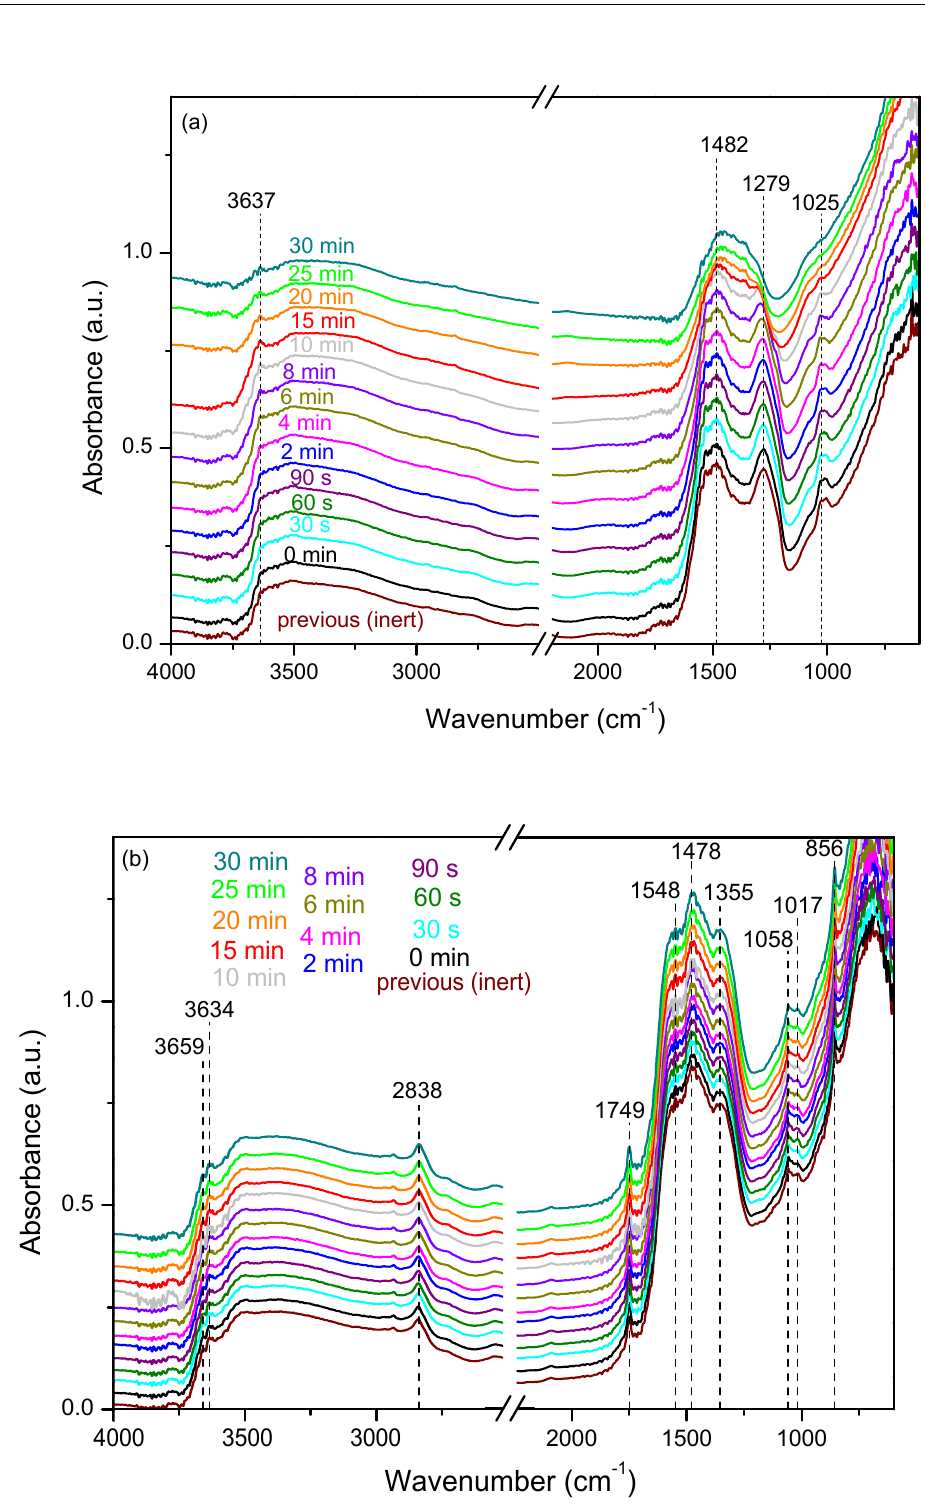
Figure 6. In situ DRIFTS spectra of CZ ( a ) and Ba6/CZ ( b ) during the reduction step in H 2 , at 300 °C.